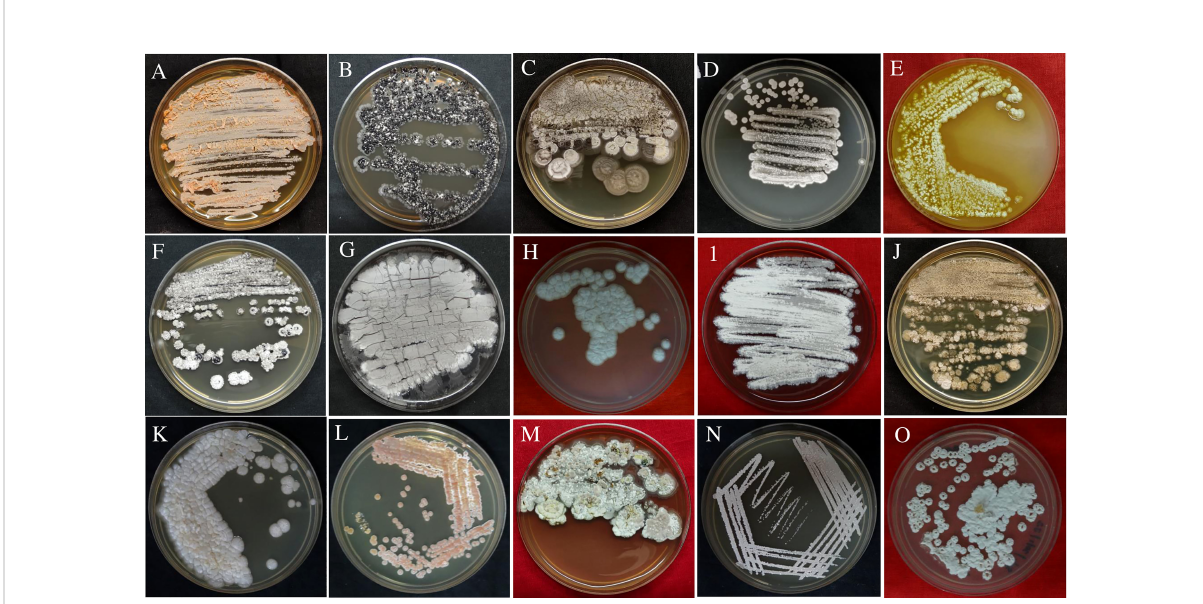
FIGURE 1 Pure culture plates of endophytic actinobacterial isolates obtained from root and leaf tissues of ten orchid species of Assam, India. The isolates streaked onGLM media were (A) DDRA3; (B) DCLA2; (C) DDLA2; (D) DNRA2; (E) CARA1; (F) DNRA1; (G) DMRA3; (H) DFRA2; (I) DCRA3; (J) DDLA1; (K) RVRA8; (L) RRLA1; (M) DMLA8; (N) DNLA1; (O)